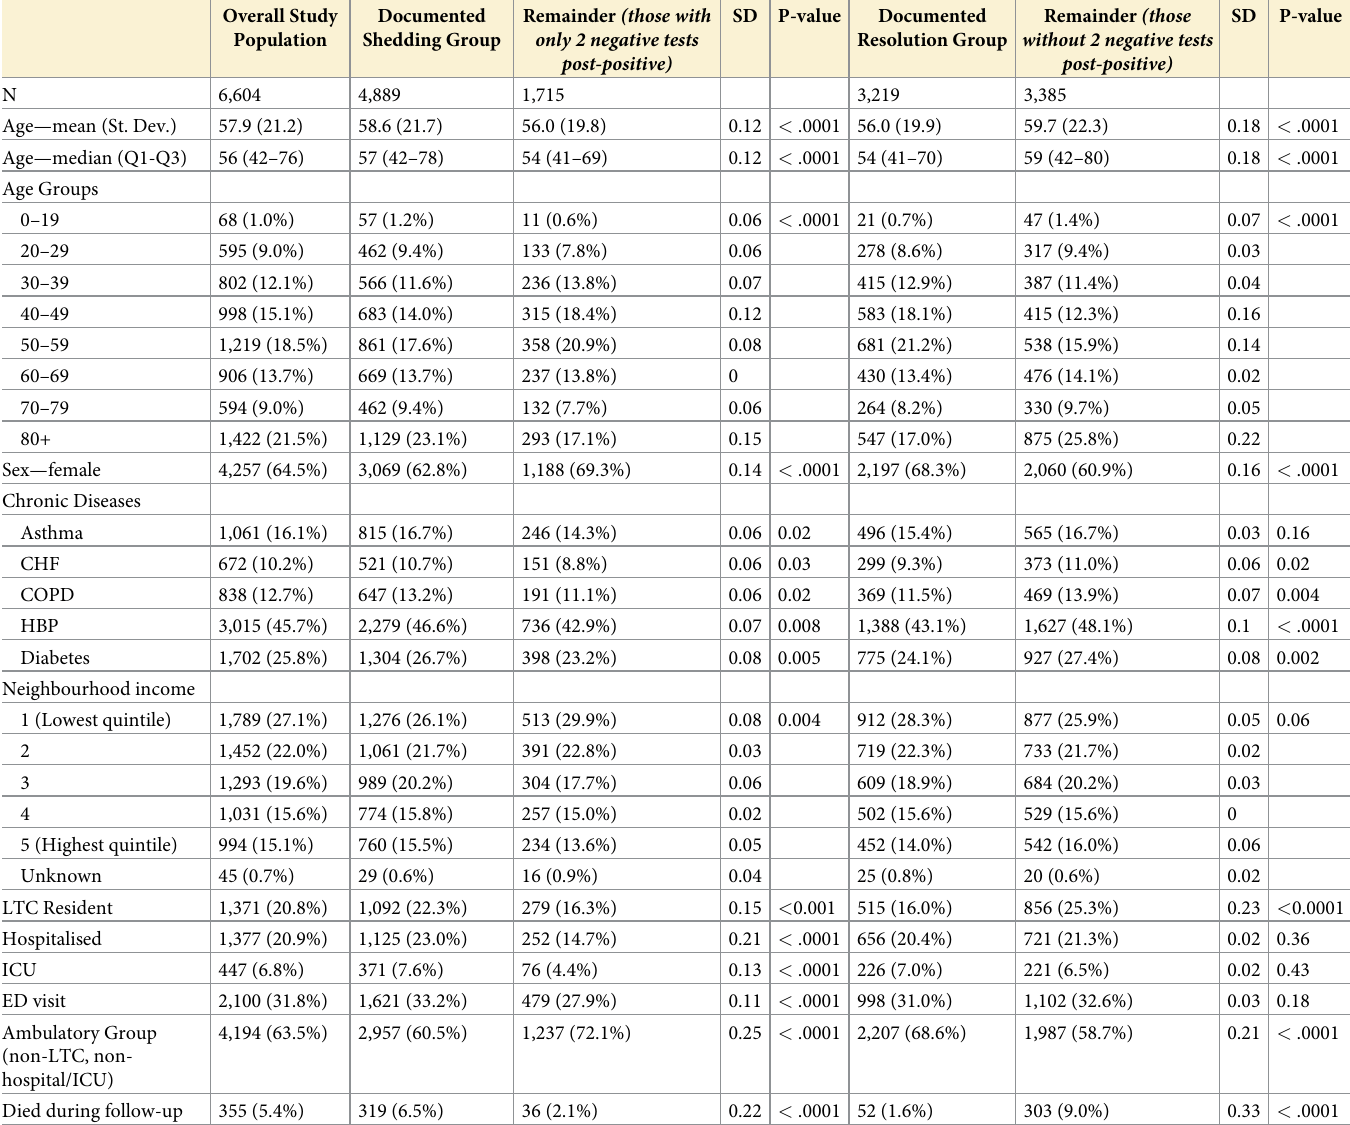
Table 1. Baseline characteristics at time of first positive test for study cohort overall and for subgroups contributing to documented shedding and documented res- olution estimates (n (%) unless otherwise stated). Overall Study